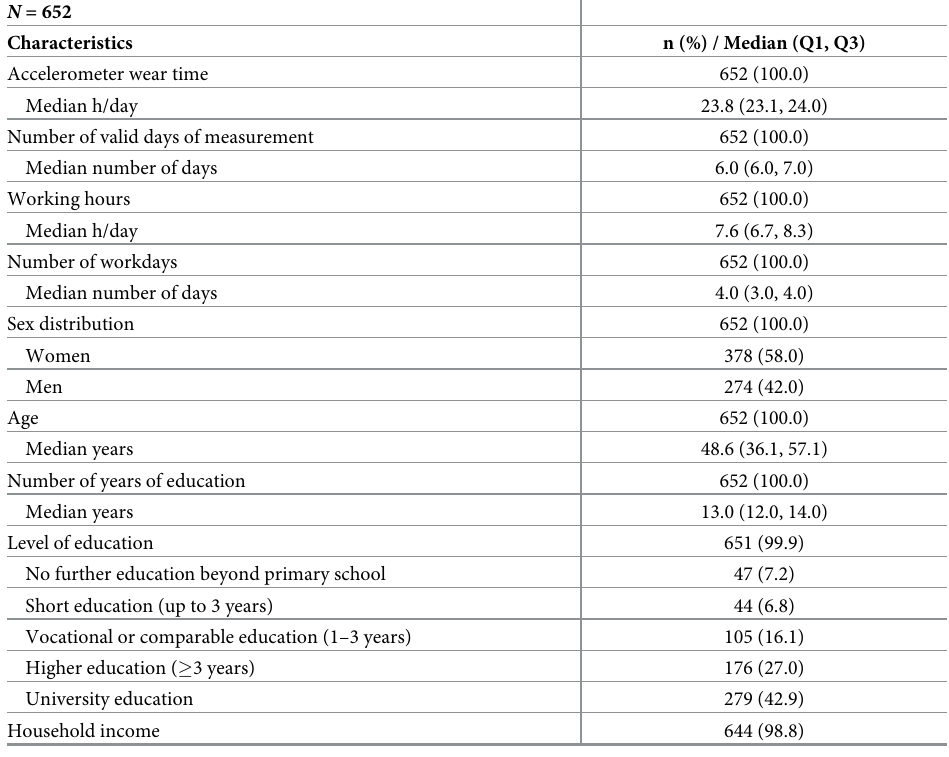
Table 1. Characteristics of 652 adults participating in the fifth examination of the Copenhagen City Heart Study. N = 652